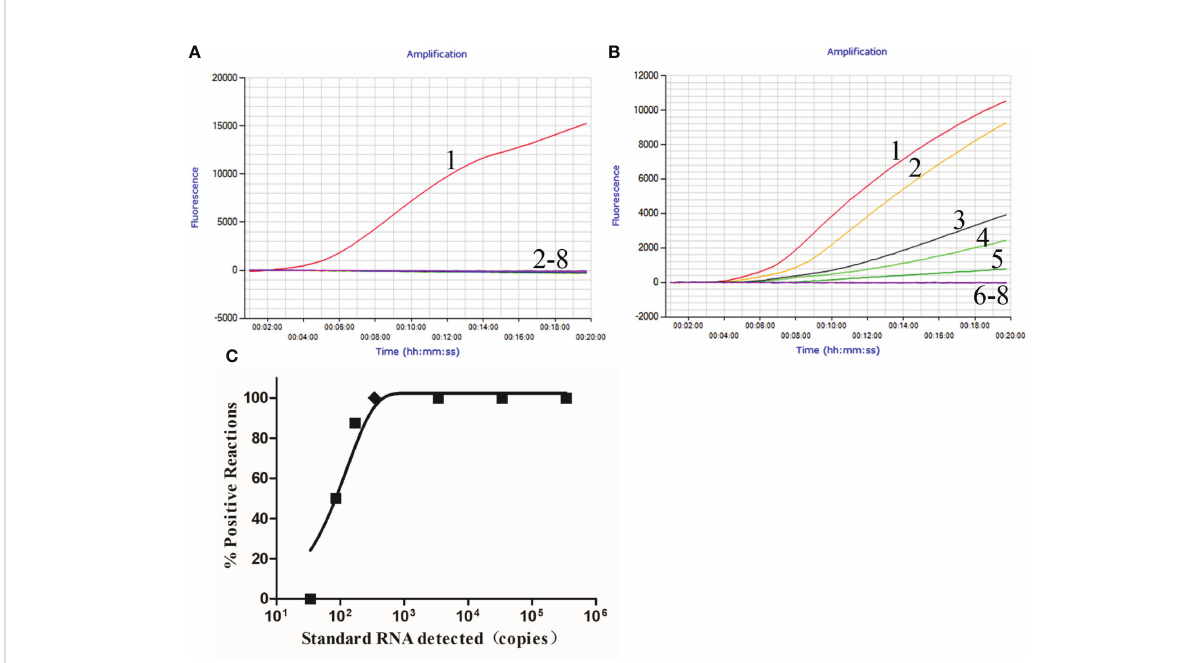
FIGURE 1 Performance of the HEV qRT-RPA assay. (A) Evaluation of the analytical speci fi city of the qRT-RPA assay. Lines 1 – 8: HEV, PRRSV, CSFV, FMDV, PRV, PCV2, PPV, and ddH 2 O. (B) Fluorescence ampli fi cation curves of qRT-RPA. Lines 1 – 7: 3.4 × 10 6 – 3.4 × 10 0 copies/ m l; line 8: ddH 2 O. (C) Probit regression analysis of the RT-qRPA assay using the data of the positive samples from each of the eight replicates. The limit of detection at 95% probability (154 copies/ m l) is depicted by a